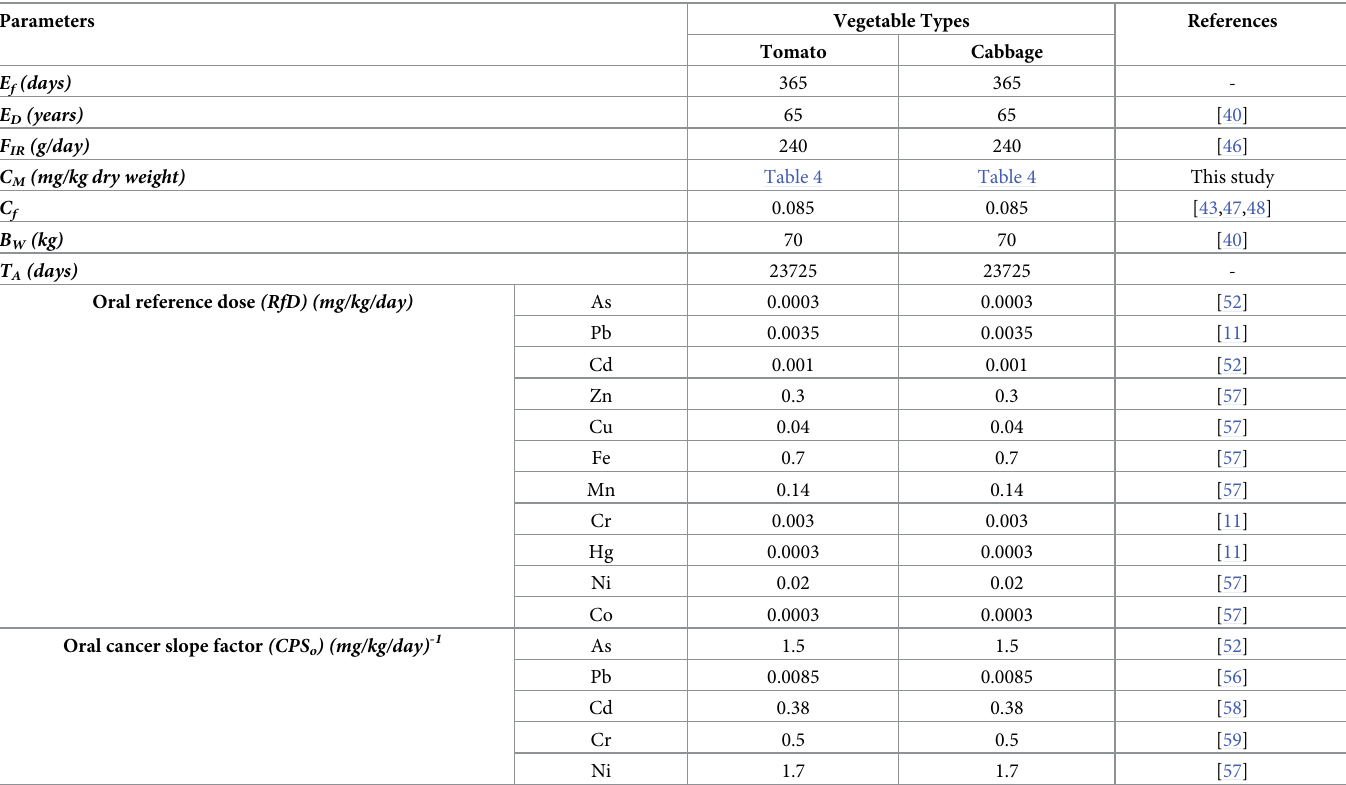
Table 1. Parameters and variables used in the calculation of EDI, THQ and